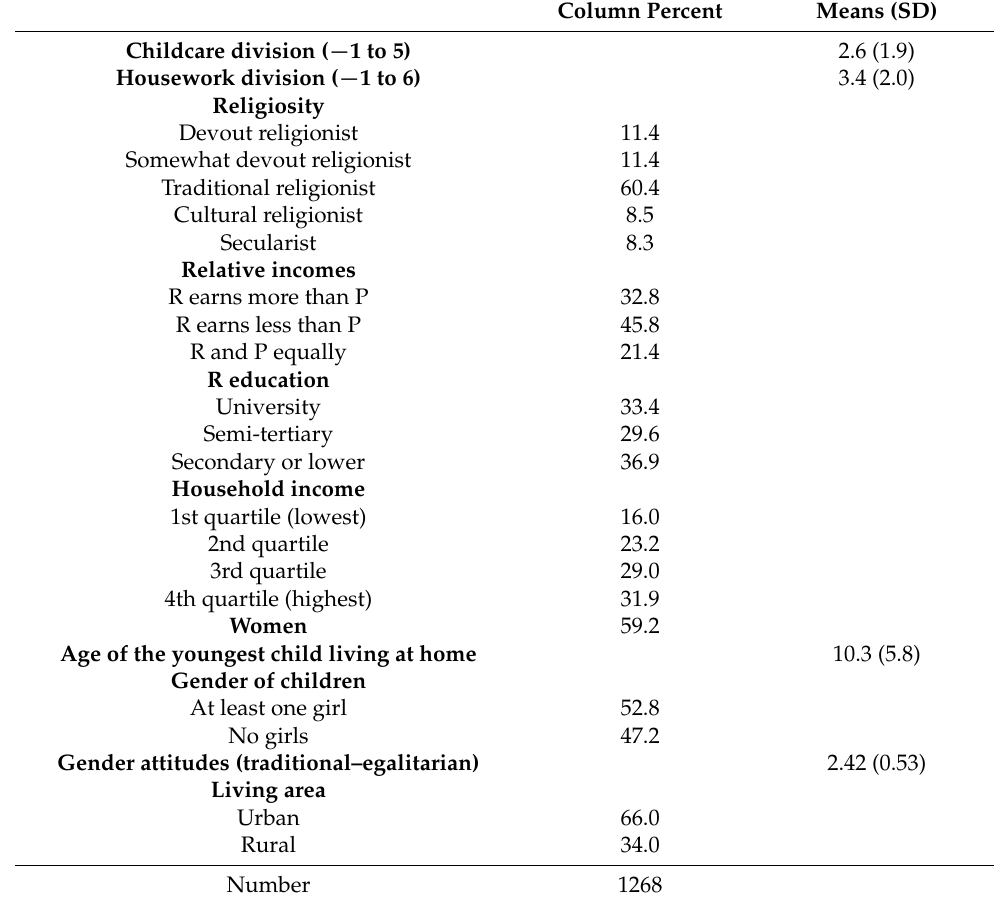
Table 1. Descriptive sample statistics, percent and means (standard